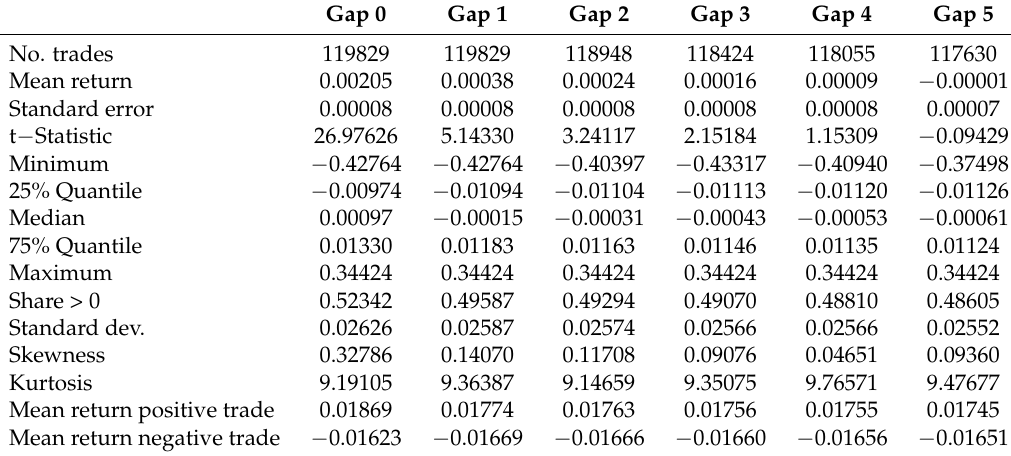
Table 3. Key return characteristics on the level of individual round trip trades for the random forest (RF) model when investing in the top-3 and flop-3 coins, after transaction costs of 30 bps. Each column represents the gap between signal generation and signal execution, i.e., gap 0 refers to signal generation at the closing price of bar t and execution at the opening price of bar t + 1. Gap 1 refers to a delayed execution at the closing price of bar t + 1, gap 2 to a delayed execution at the closing price of bar t + 2, and so